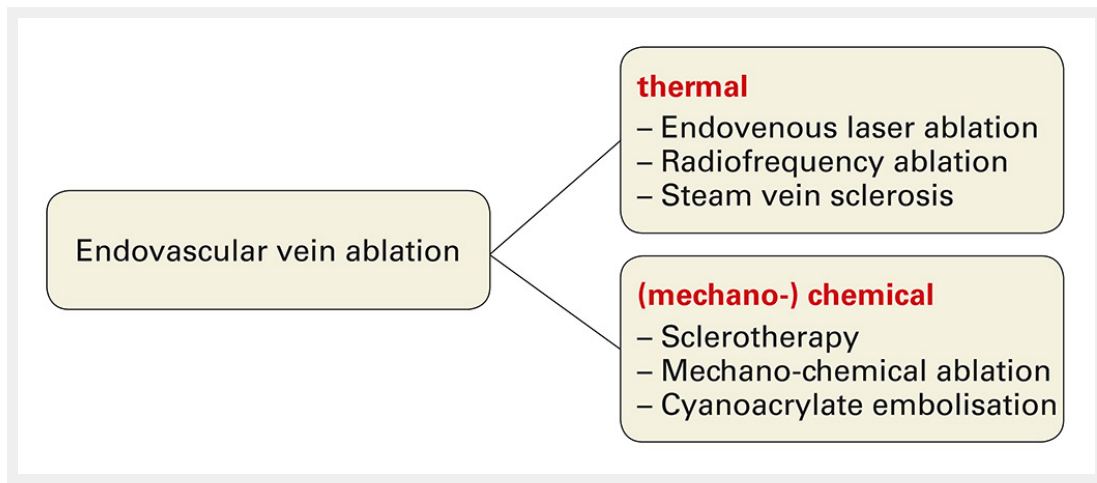
Figure 1 Overview of the different techniques of endovascular vein